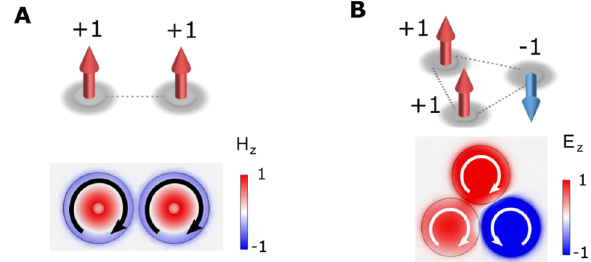
Figure 2: Realizing the Ising Hamiltonian in nanolasers. (A) Ising spinswithFMexchangeinteractionimplementedbythe TE 01 modes in coaxial nanolasers. The black arrows show the direction of the azimuthal electric fi elds. (B) A three-element Ising Hamiltonian with AF couplings realized using a TM 01 resonant mode of the nanodisk lasers. One of the possible degenerate ground states is presented here.Thewhitearrowsshowthedirectionoftheazimuthalmagnetic fi elds within the